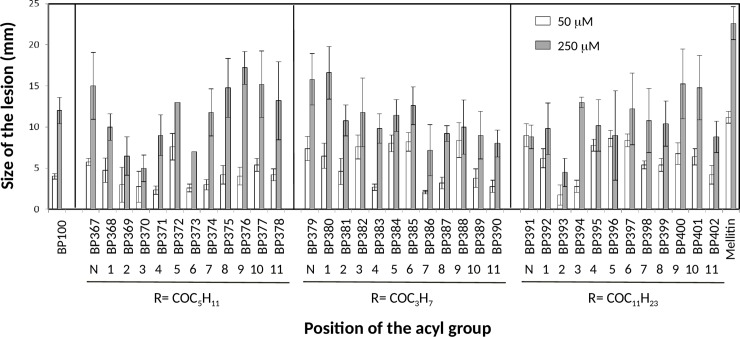
Effect of the lipopeptides derived from BP100 at 50 and 250 μM on the size of the lesions in infiltrated tobacco leaves.This effect was compared to melittin. Vertical bars within each column indicate confidence interval at the mean. The position of the acyl group at the N-terminus is indicated by a N, and the position of the acylated Lys by numbers 1 to 11. The type of the acyl group is depicted as R = COC5H11 (hexanoyl), R = COC3H7 (butanoyl) and R = COC11H23 (lauroyl).